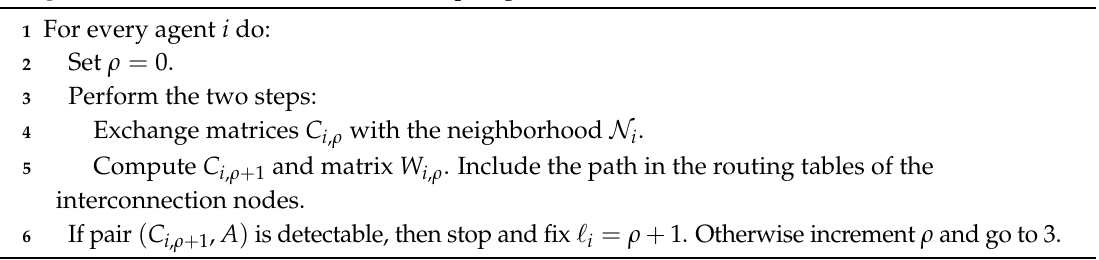
Algorithm 1: Distributed Observer Setup